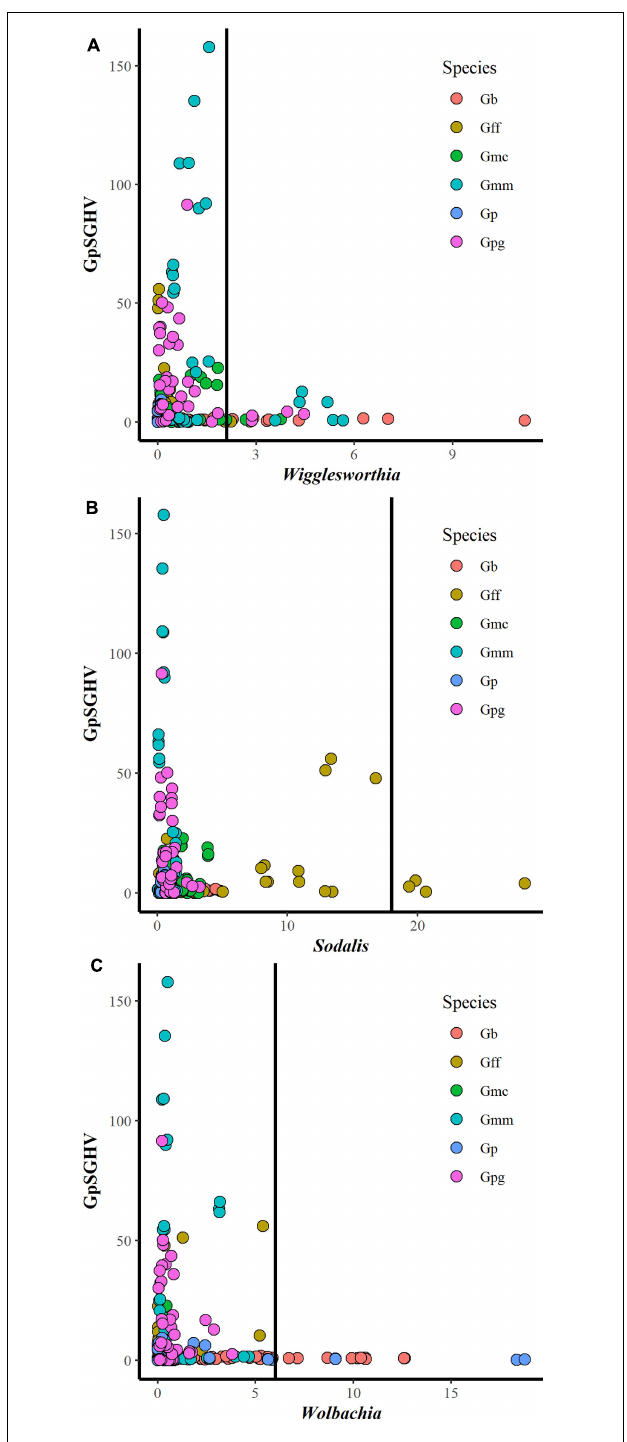
FIGURE 2 | Interaction between GpSGHV relative density and the relative density of Wigglesworthia (A) , Sodalis (B), and Wolbachia (C) in six taxa of tsetse flies. Tsetse adults were injected with GpSGHV and the density of GpSGHV and tsetse symbionts were analyzed by qPCR and the data were normalized against control flies and zero time of injection. The vertical bar indicates the tsetse symbiont relative density to limit the relative density of GpSGHV to